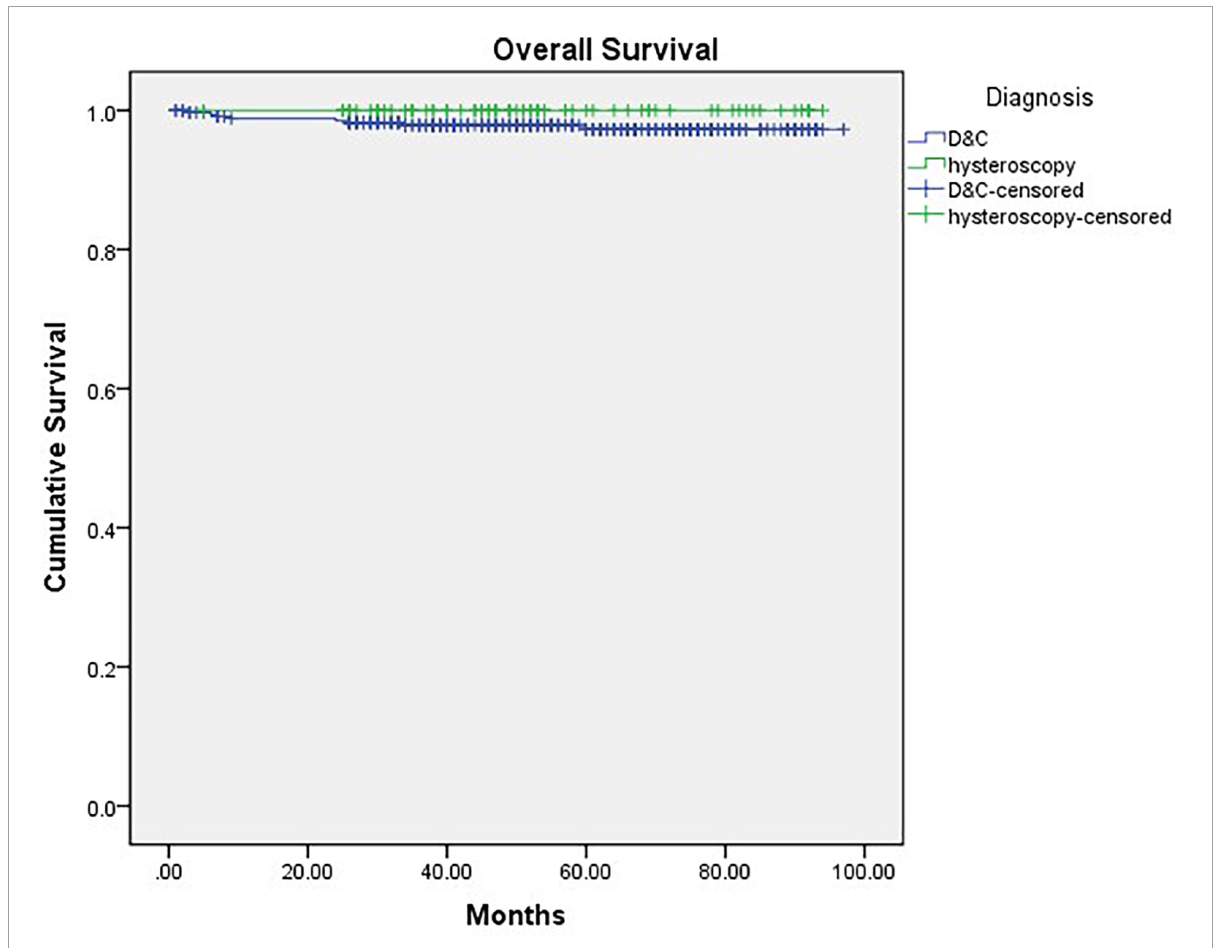
FIGURE3 Kaplan-Meier curve of overall survival grouped by diagnostic procedure ( P =